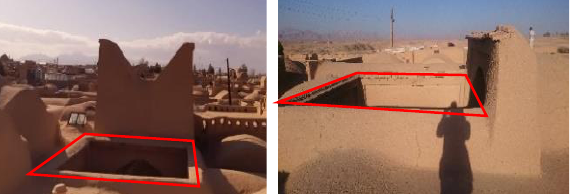
Figure 3. The central courtyard is like a deep hole in the middle of the